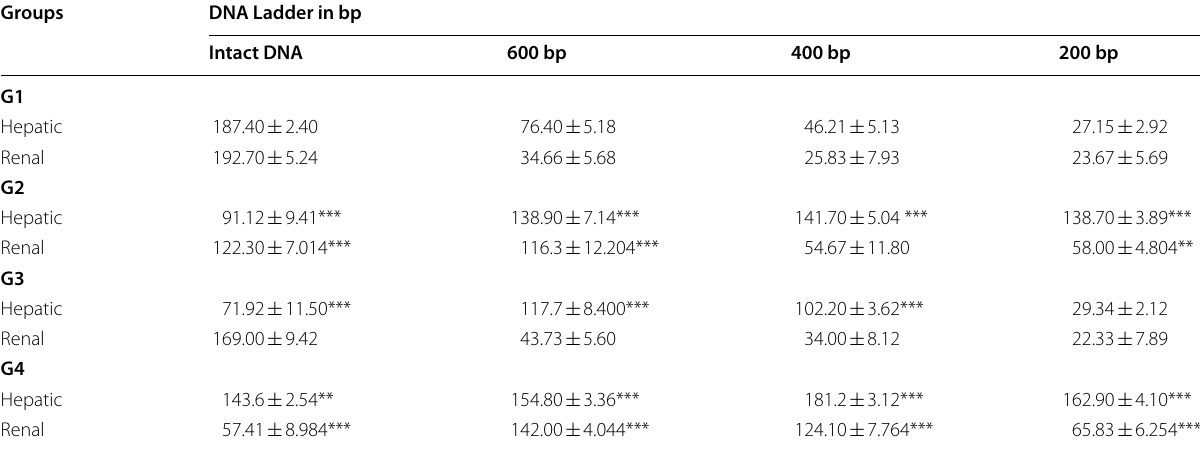
Values: means SE. one‑way ANOVA. G1: control, G2: therapeutic design, G3: short‑term prophylactic design, G4: long‑term prophylactic design. P values: No ± asterisks non‑significant ( P > 0.05), *Significant ( P < 0.05), **Highly significant ( P < 0.01), ***Very highly significant ( P < 0.001) compared to their control, using one‑ = way